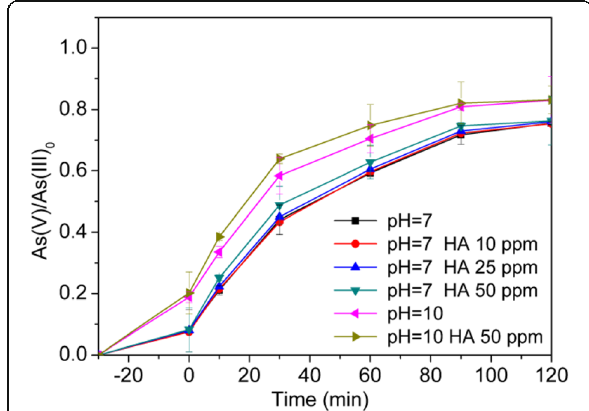
Fig. 7 Effect of HA addition on the photocatalytic arsenite oxidation. Ag@AgCl core – shell nanowires synthesized with the mole ratio of Ag nanowires:FeCl 3 = 2.32:2.20, and the experimental conditions were [Ag@AgCl] = 0.3 g/L, [As(III)] 0 = 2.0 mg/L, initial pH = 7.0, and air-equilibrated, P = 300